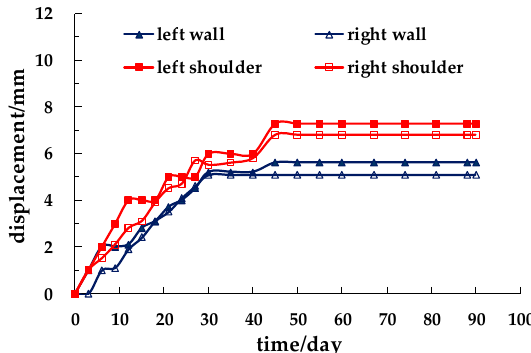
Figure 11. Displacement monitoring of pump house after reinforcement.